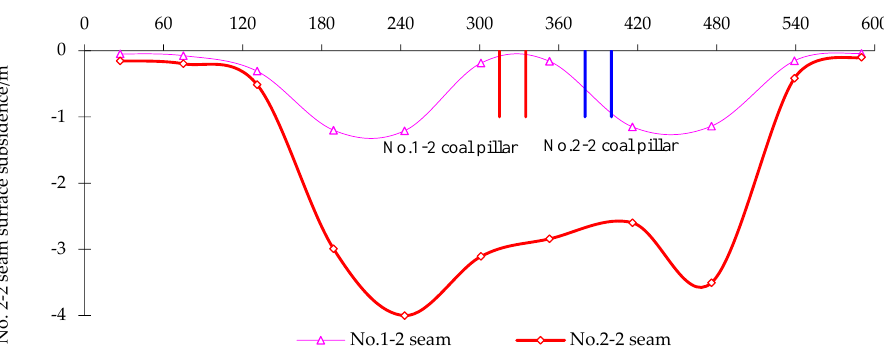
Figure 19. Surface subsidence of 2-2 seam from the physical simulation mining.